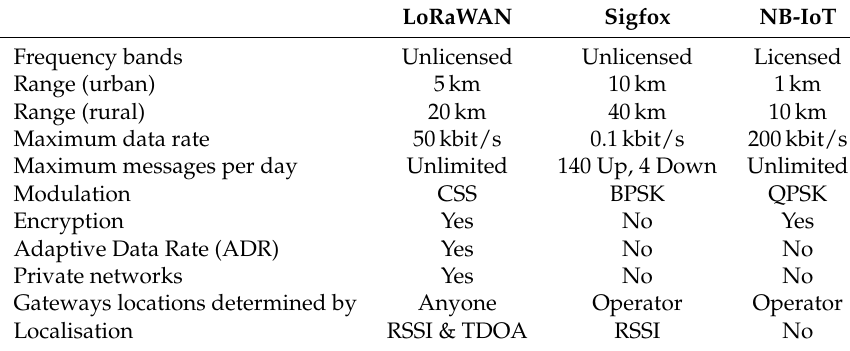
Table 1. Comparison of different Low-Power Wide Area Network (LPWAN) technologies [12]. The standard for each technology is driven by multiple organisations. The modulation schemes used are Chirp Spread Spectrum (CSS), Binary Phase Shift Keying (BPSK) and Quadrature Phase Shift Keying (QPSK); the localisation schemes used are Received Signal Strength Indication (RSSI) and Timed Difference of Arrival (TDOA). Adapted from Johnston et al.